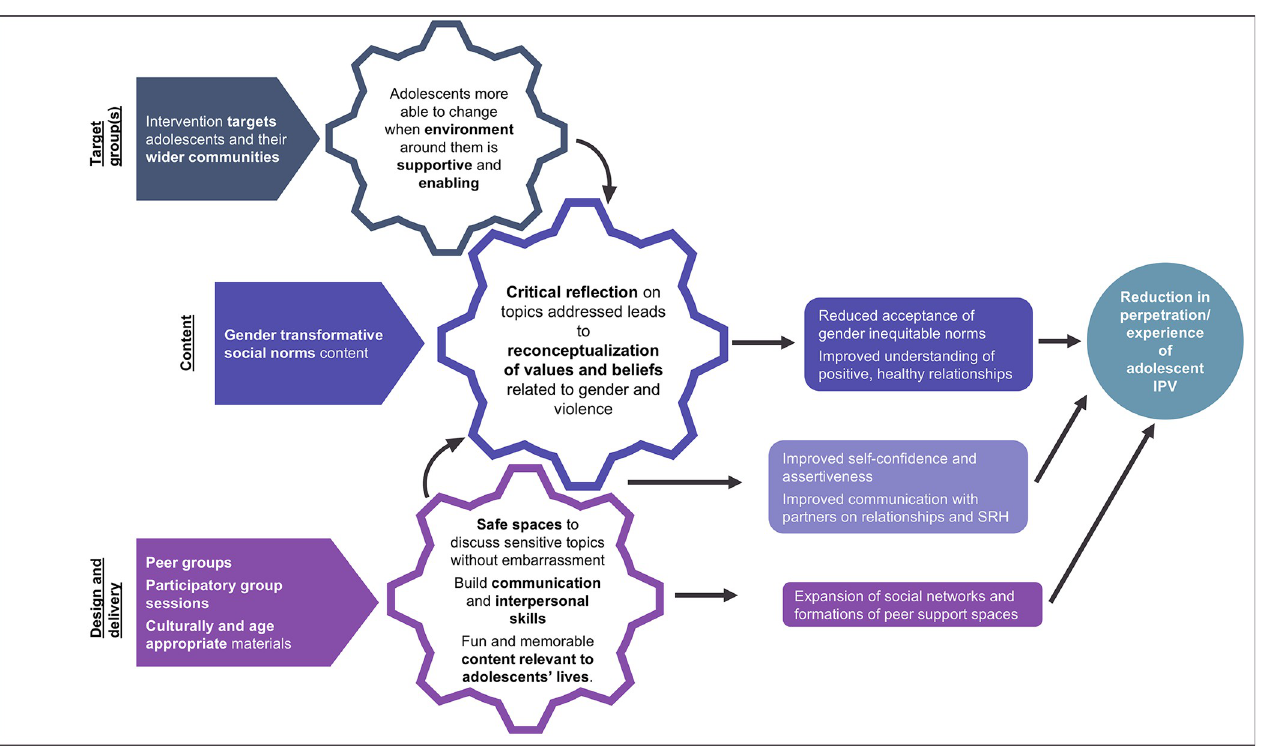
Fig 2. Programme theory for interventions to prevent adolescent